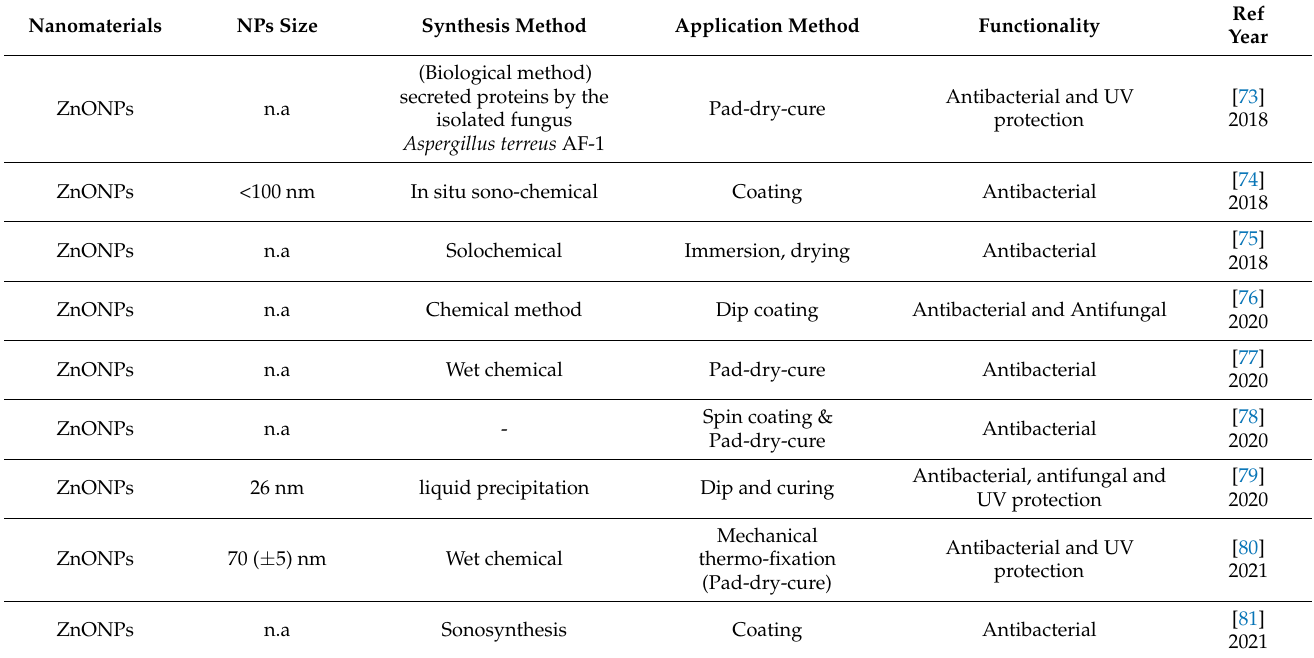
Table 4. Summary of the functionalization of cotton fabrics treated with